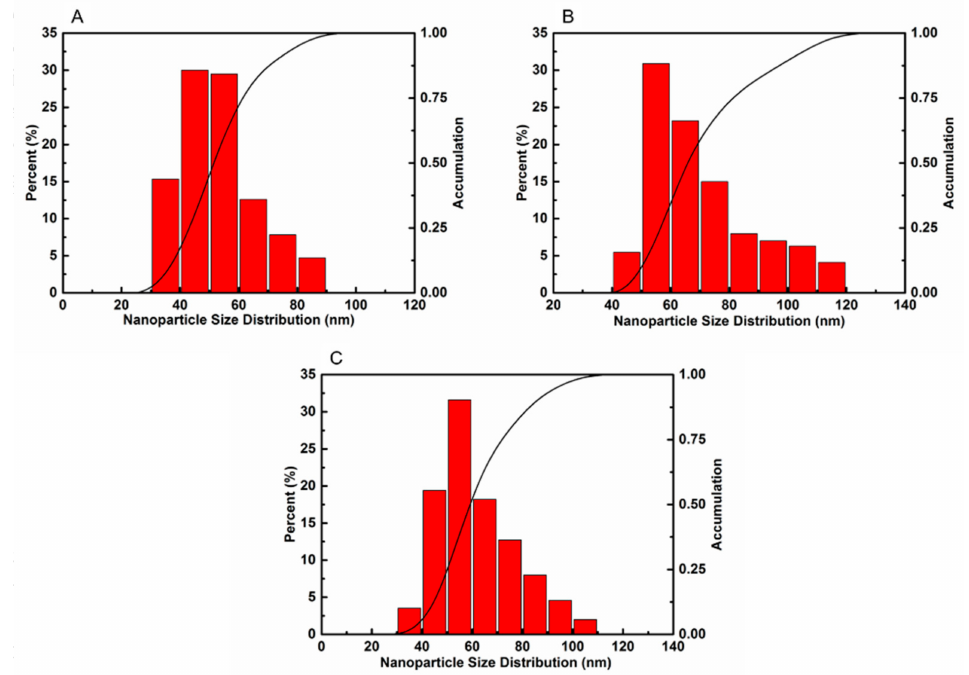
Figure 6. Hydrodynamic sizes of: ( A ) AlTi-MgO NPs; ( B ) AlTi-MgO@PDA NPs; and ( C ) AlTi-MgO@C NPs in the aqueous